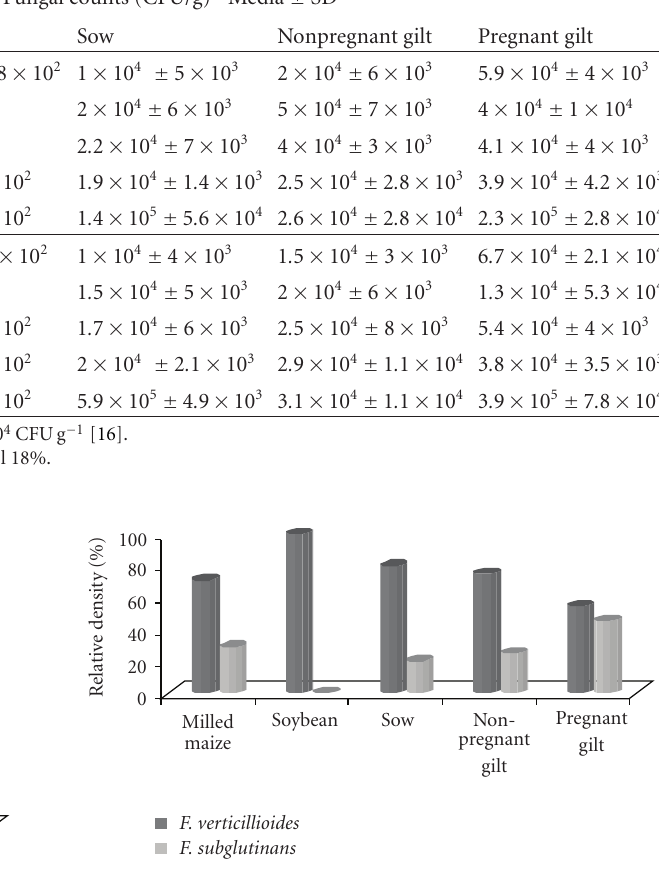
Table 2: Fungal counts (CFU/g) from raw materials and finished feed at di ff erent reproductive stages in DRBC and DG18 culture media. Culture